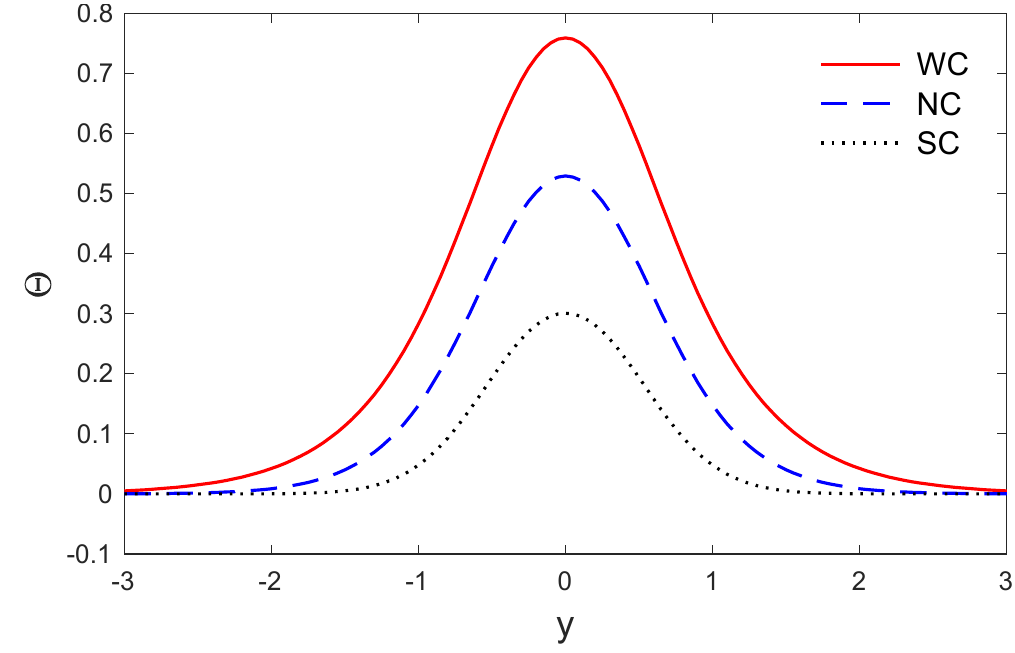
Figure 8. The variations of temperature Θ via (cid:1877) and (cid:1876) = 0.4 for strong normal and weak con- ductivities.